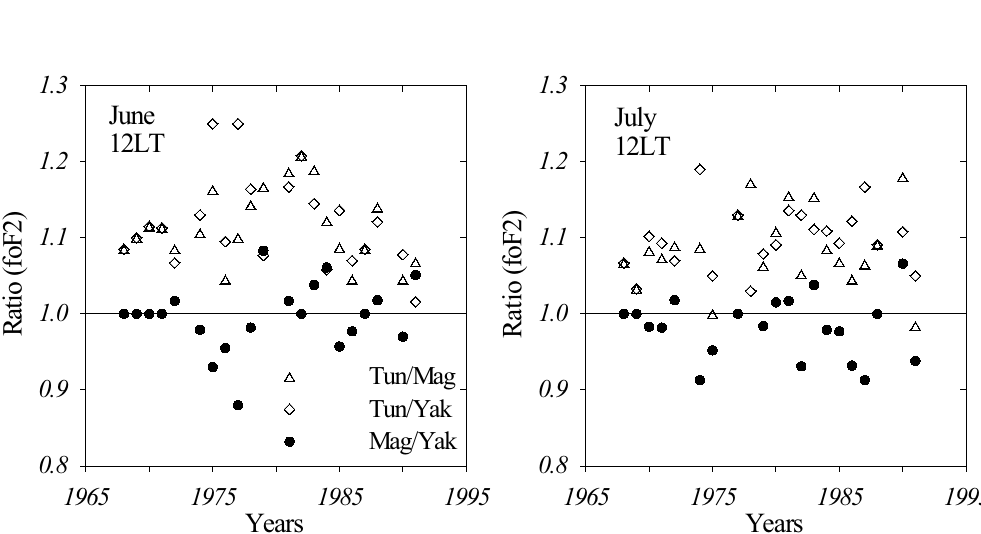
Figure 3. Noontime June and July monthly median foF 2 ratios for Tunguska/Magadan (triangles), Tunguska/ Yakutsk (diamonds), and Magadan/Yakutsk (circles) calculated over the (1968–1991)